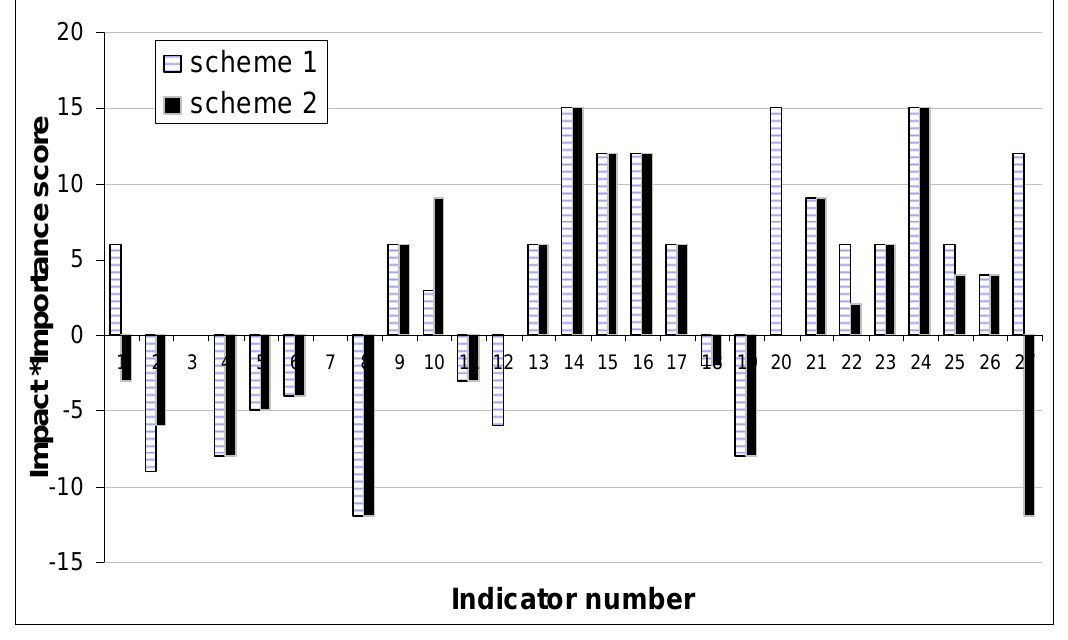
Figure 3. Breakdown of score by different